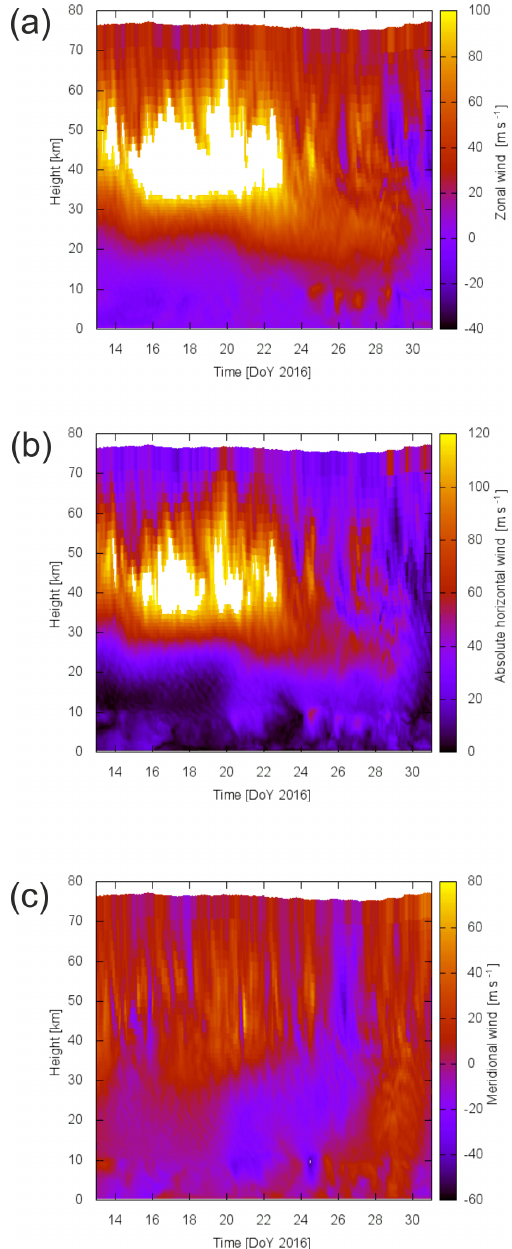
Figure 14. Zonal (a) , absolute horizontal (b) , and meridional (c) wind at 67.84 ◦ N, 20.41 ◦ E (Kiruna: 67.86 ◦ N, 20.24 ◦ E) from ECMWF data (European Centre for Medium-Range Weather Fore- cast; ECMWF data were provided by Andreas Dörnbrack, DLR).